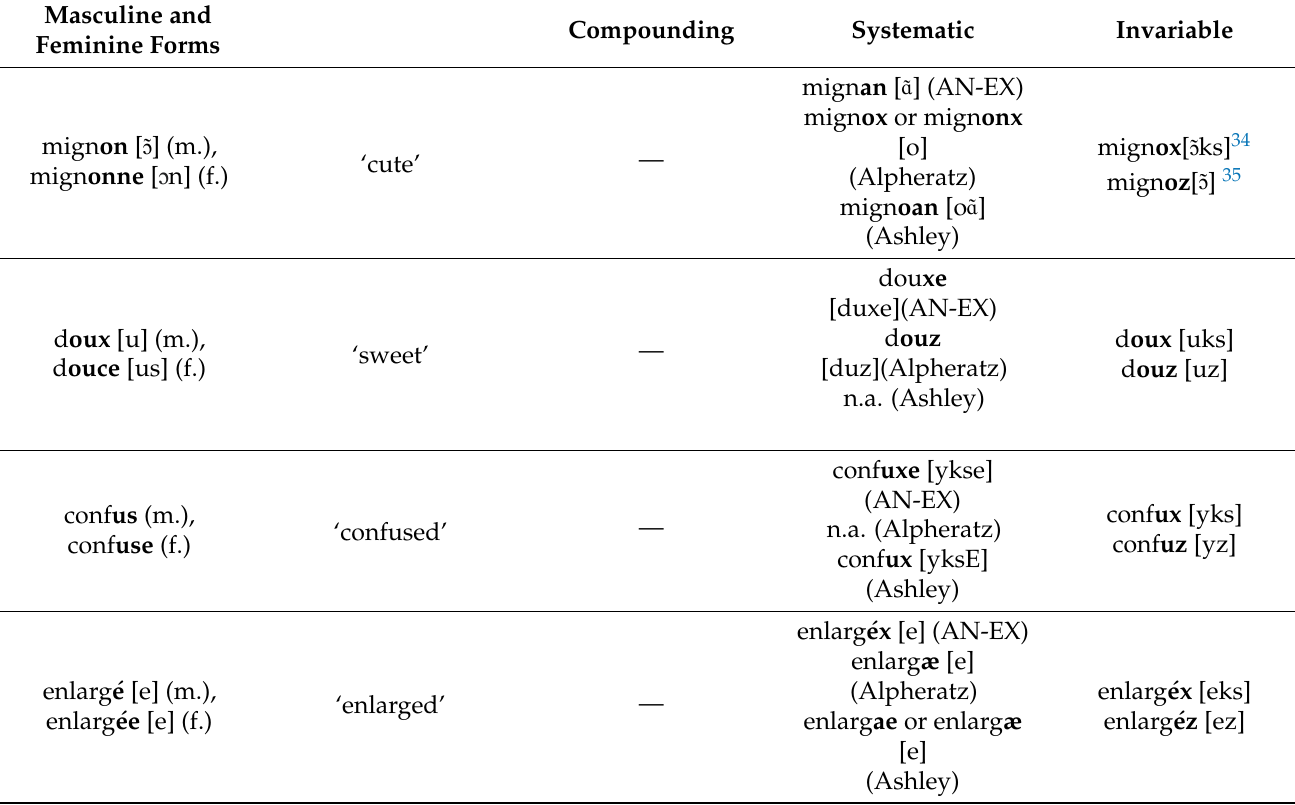
Table A2. Three approaches to forming non-binary adjectives. Table 2. Masculine and Feminine